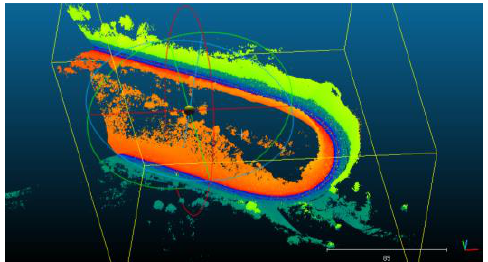
Figure 1. Area of study